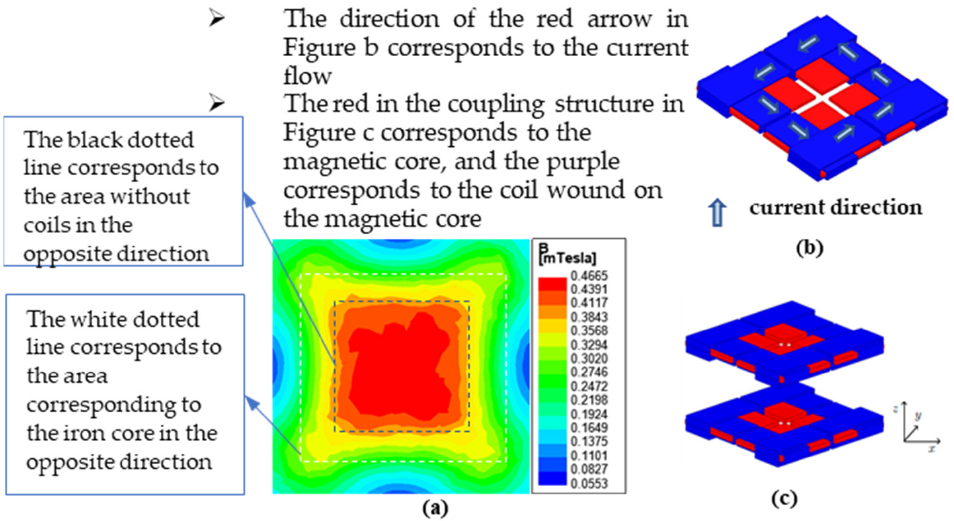
Figure 9. Magnetic field distribution, current flow, and coupling method: ( a ) XY plane magnetic field distribution; ( b ) XY plane magnetic field distribution; ( c ) schematic diagram of coupling structure space.